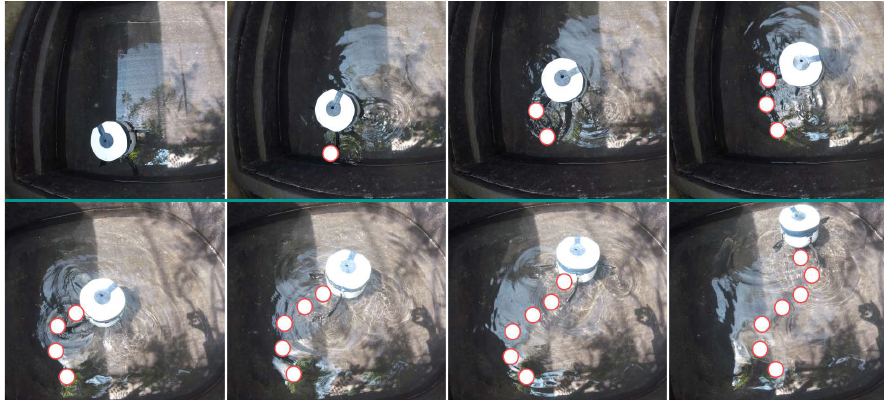
Figure 10. Video Sequences of S-Shape turning maneuver of the robotic